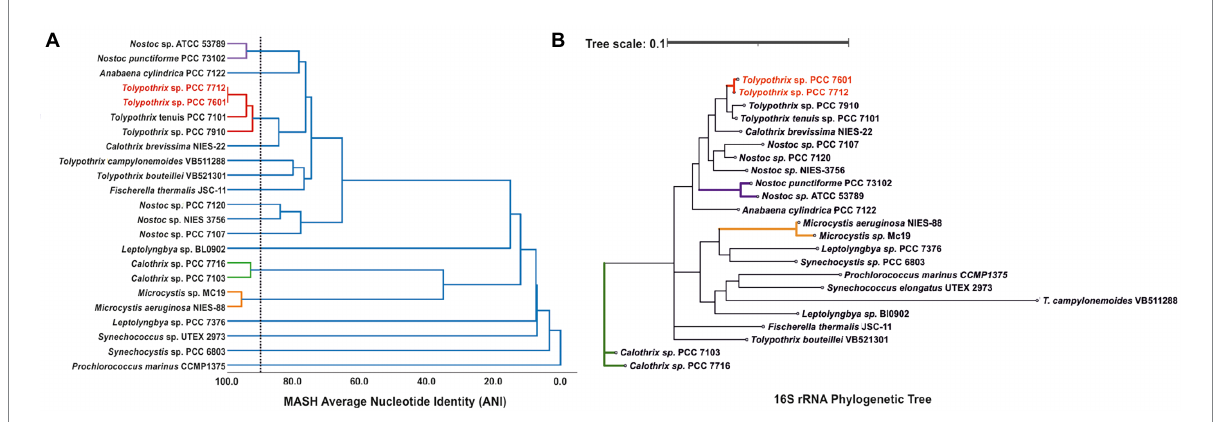
FIGURE 1 (A) The tree shows genome sequence similarity of 23 cyanobacterial strains including PCC 7601 and PCC 7712 as calculated by dRep MASH ANI clustering. The dotted line shows the primary ANI clustering threshold, which was set to 90%. (B) The phylogenetic tree indicates the distances between these strains based on 16S rRNA homology.